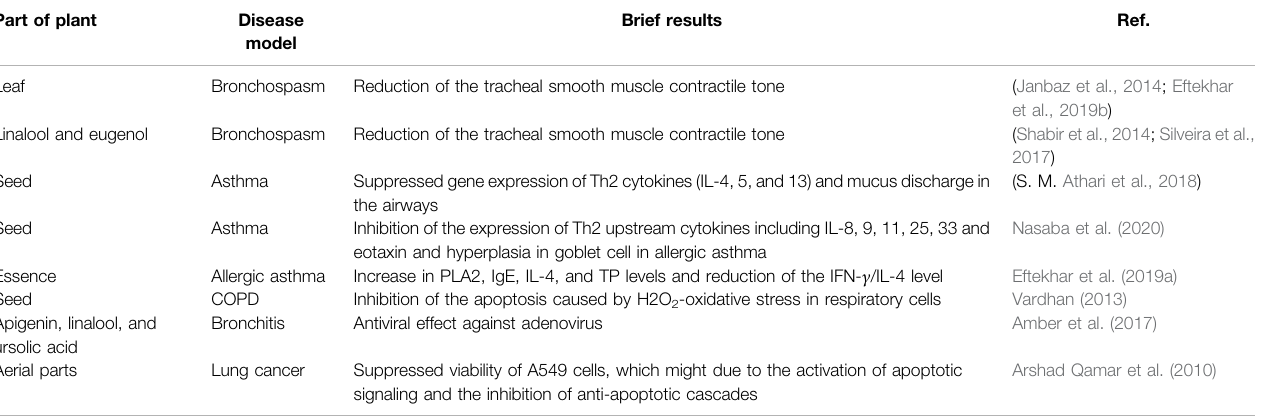
TABLE 2 | Summarized experimental effects of O. basilicum on the respiratory system. Part of